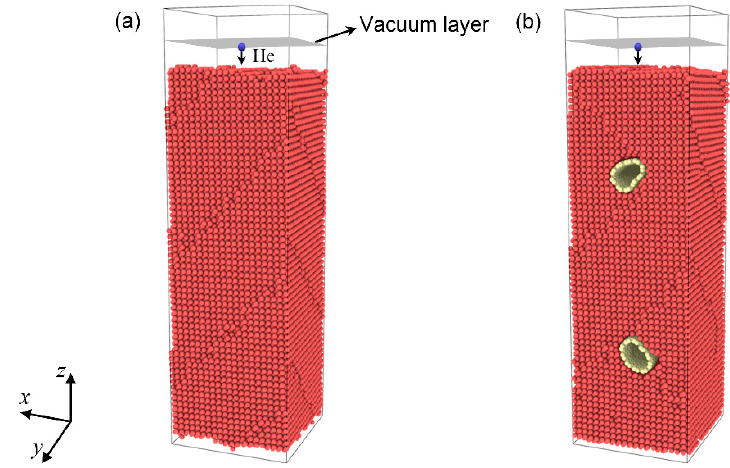
Figure 1. Simulation models: ( a ) bcc-Fe; ( b ) single-walled carbon nanotube (SWCNT)/Fe composite. The red, yellow, and blue balls denote the Fe, C, and He atoms,